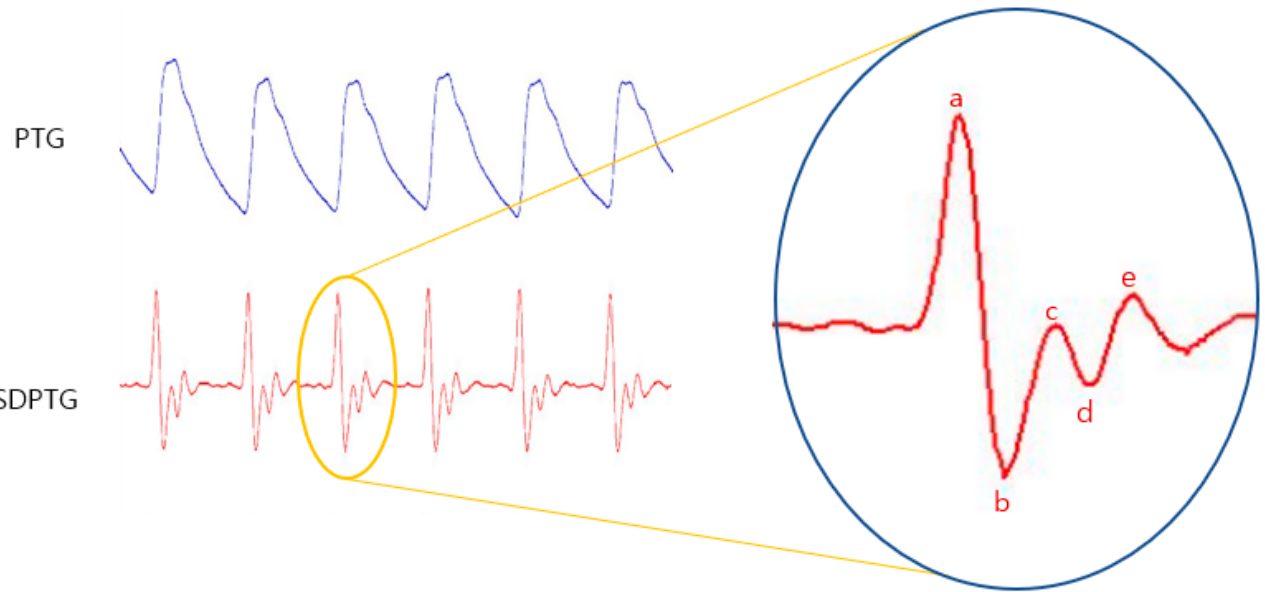
Figure 1. Photoplethysmogram (PTG) and second derivative PTG (SDPTG)